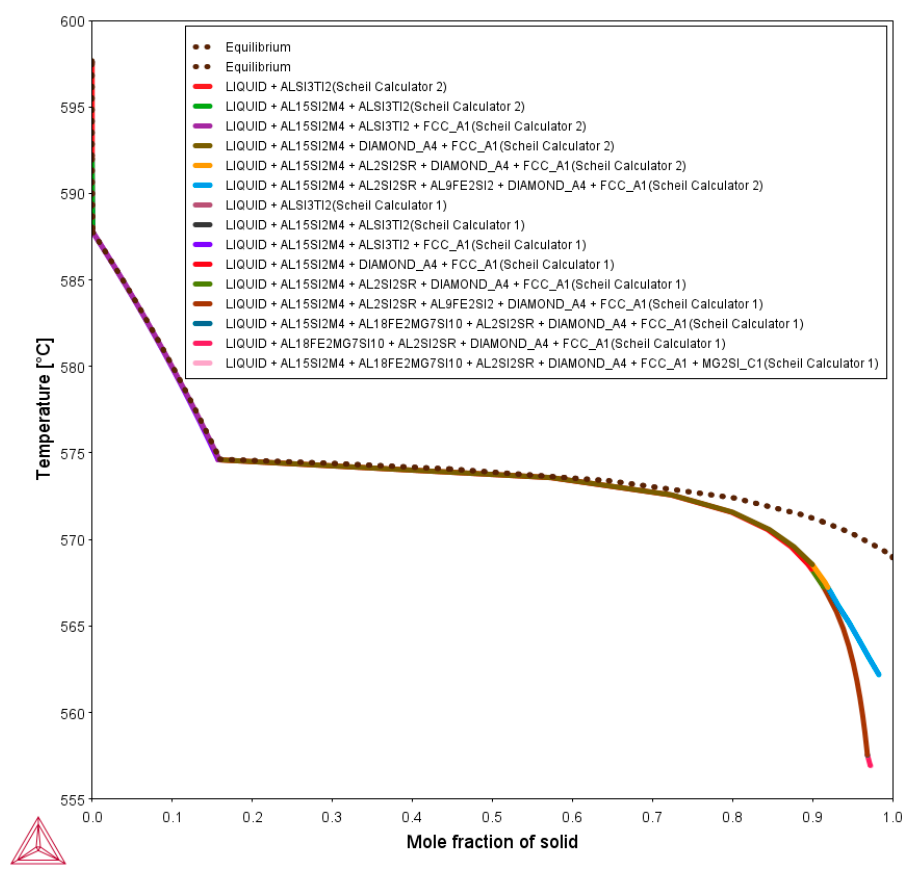
Figure 7. Non-equilibrium solidification curves of AlSi10MnMg alloy, obtained using different solidification models.